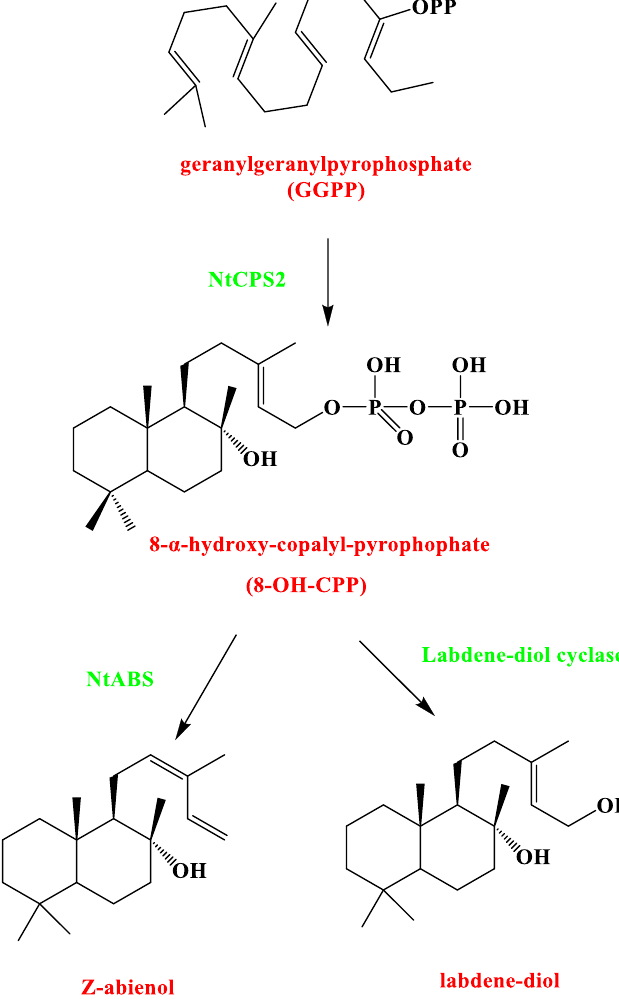
Figure 4. Metabolism process of diterpenoids from ladanum.